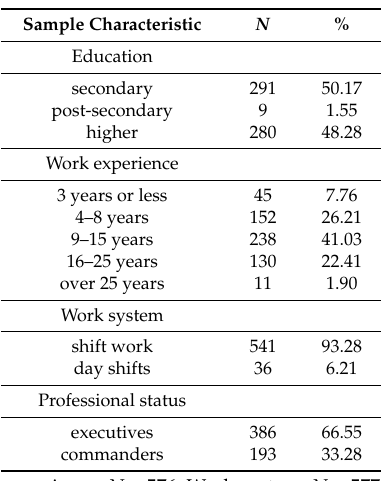
Table 2. Sample characteristics in education and work experience ( N =